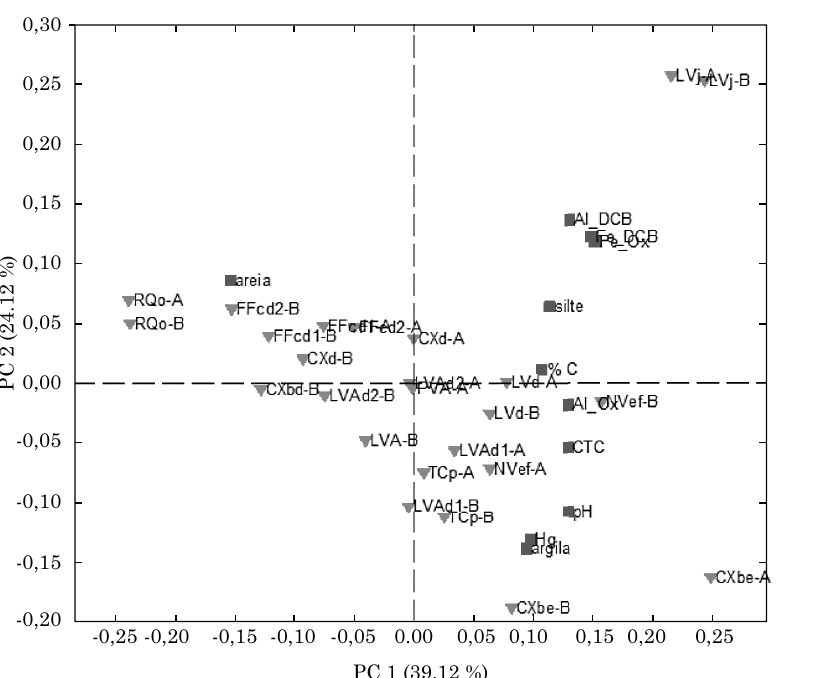
Figura 4. Gráfico biplot da primeira componente principal (pc1) versus a segunda componente principal (pc2) para análise de componentes principais (pca) considerando-se todas as características físicas e químicas das amostras